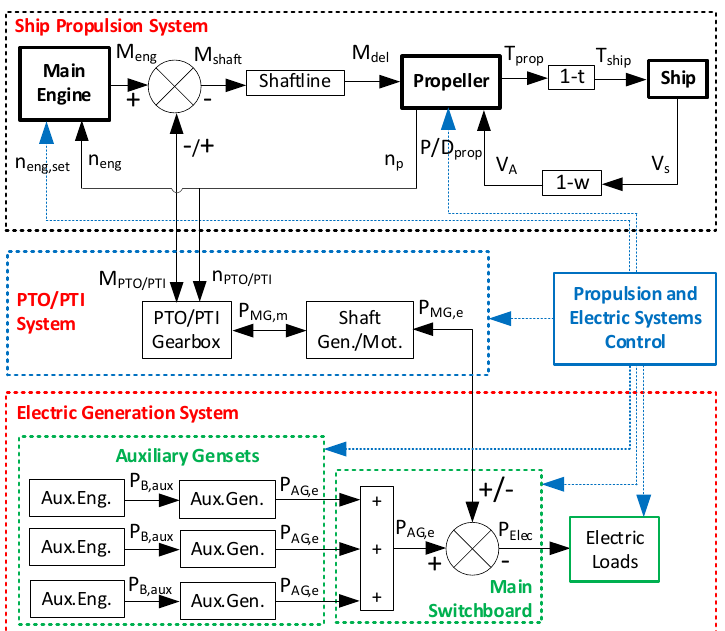
Figure 2. Model structure of the integrated ship propulsion and electric generation systems.